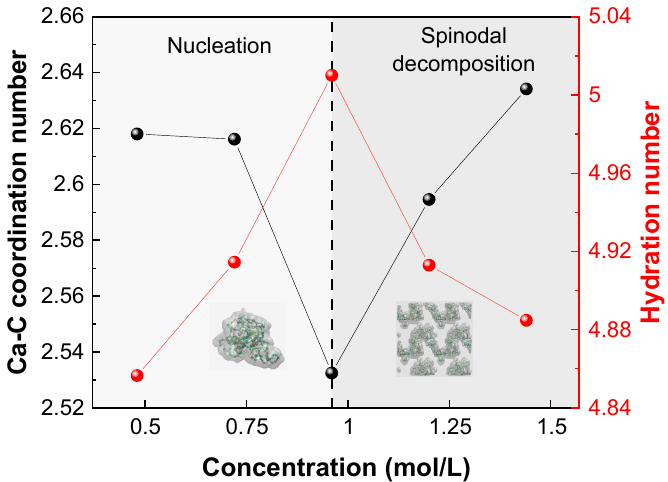
Figure 5. Ca-C coordination number and hydration number of aggregates for various CaCO 3 concen- trations at 360 K. There are two phase-separation pathways: nucleation and spinodal decomposition. The evolution of PNCs at 0.96 mol/L belongs to the nucleation zone. The dotted line is defined as the boundary for two pathways.